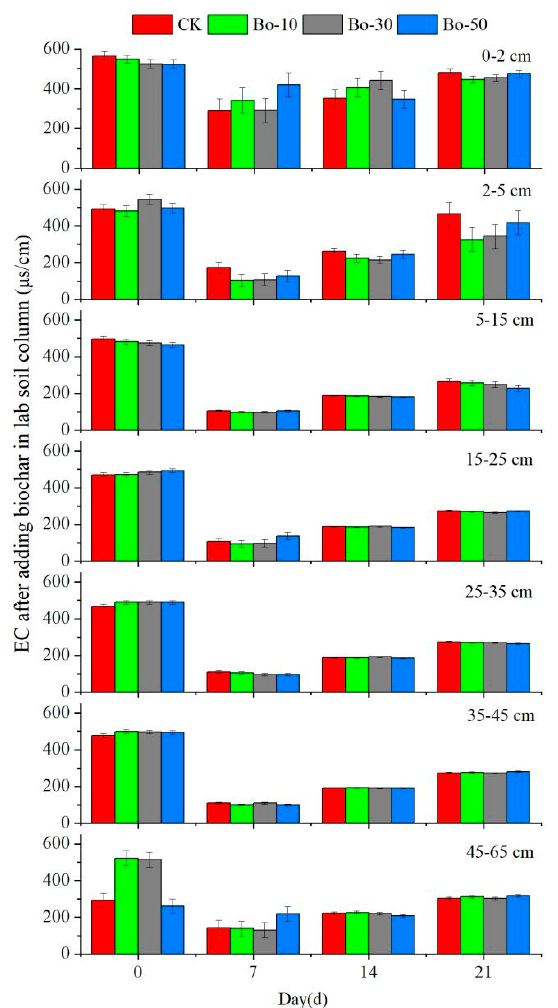
Figure 3. Variations of EC after adding straw biochar from lab soil column (0–65 cm) simulation experiment. Data are presented in the average with standard error bars ( n = 3).